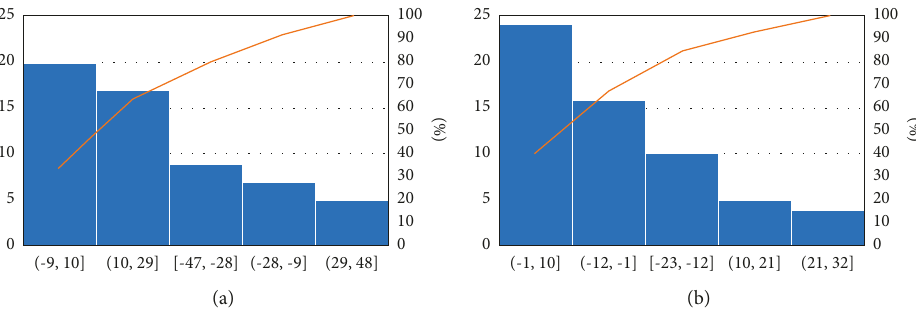
Figure 13: The difference between bus arrival time and timetable. (a) The difference between bus arrival time and timetable in Group A. (b) The difference between bus arrival time and timetable in Group